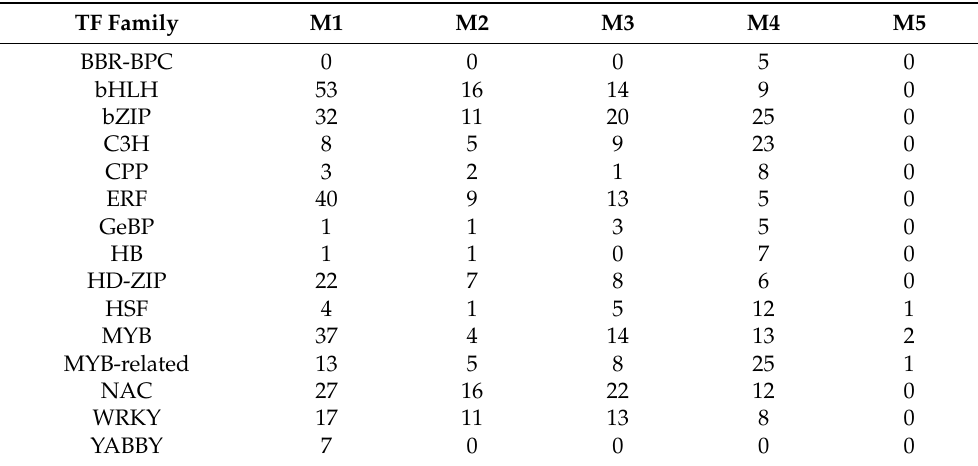
Table 2. Numbers of select genes encoding transcription factors (TFs) found in Modules 1–5.